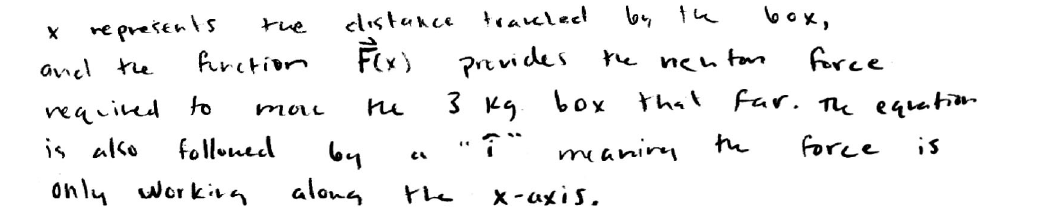
FIG. 10. Example of description when interpreting the force-position